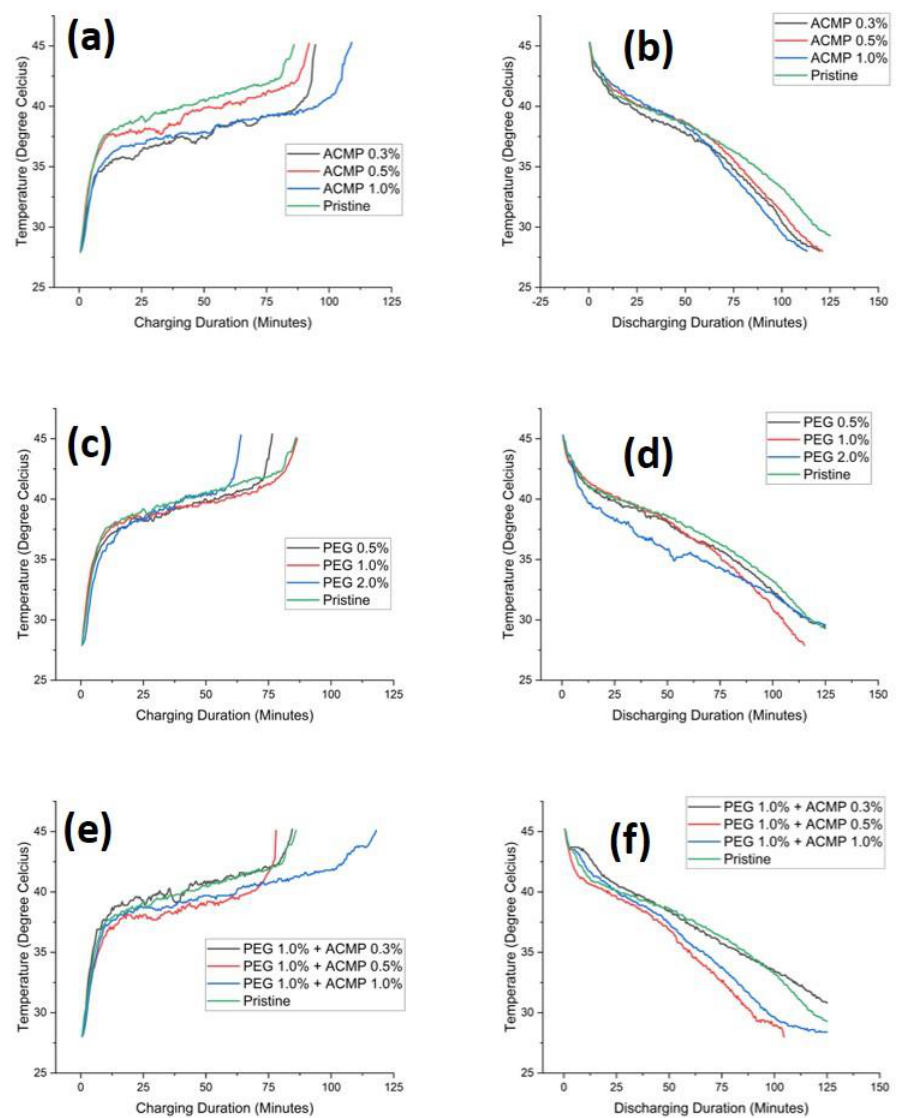
Figure 5. Charging and discharging rates of PCM mixed with different weight ratios of ( a , b ) ACMPs 0.3%, 0.5%, and 1%, ( c , d ) PEG 0.5%, 1%, and 2%, and ( e , f ) ACMPs 0.3%, 0.5%, and 1% at PEG Table 2. Enhancement of charging and discharging rates of phase change material (PCM) with ad- ditives.